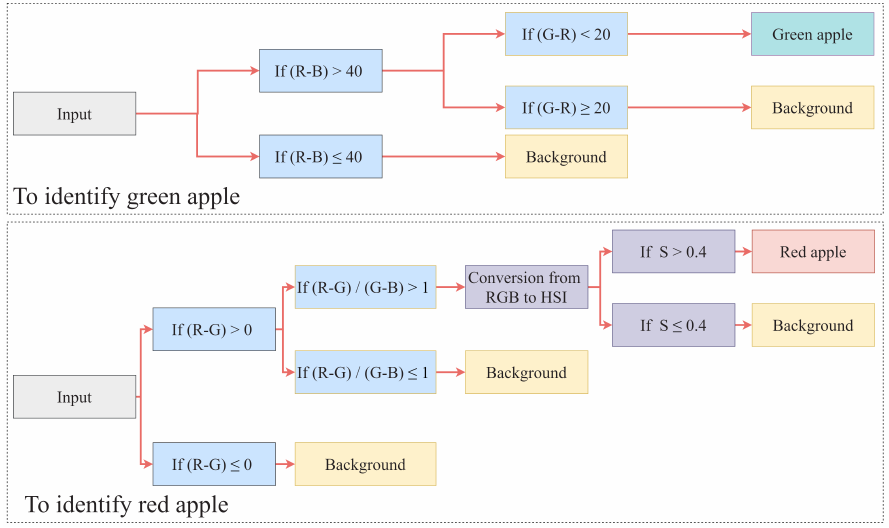
Figure 3. Flowchart of different steps in fruit segmentation. (Adapted with permission from Ref. [13]. 2012, Zhou et